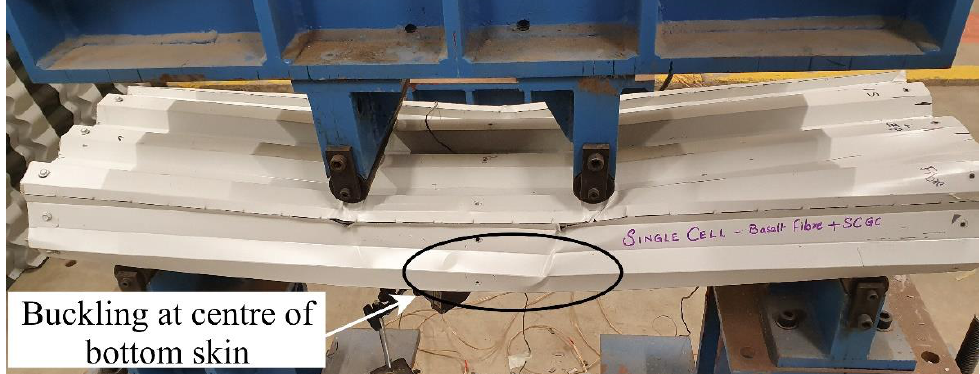
Figure 10. Compression in bottom skin due to buckling.